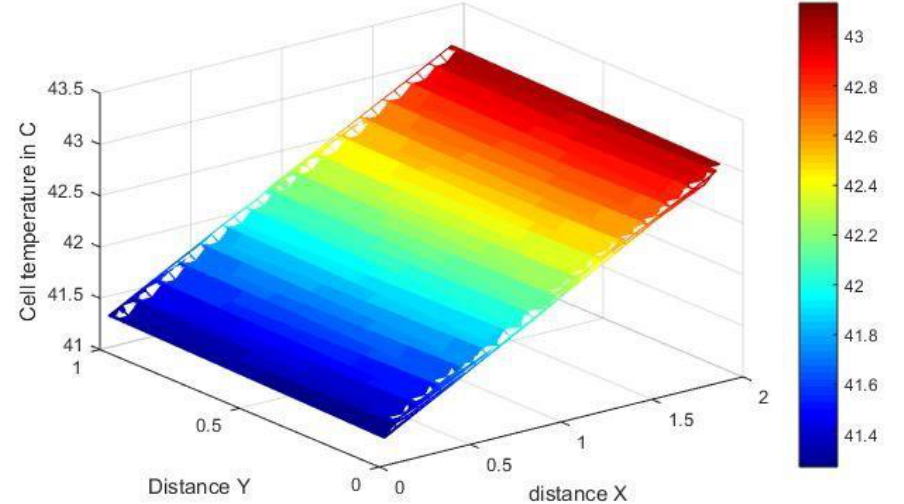
Figure 17. Analytical temperature contour for hybrid solar panel system.